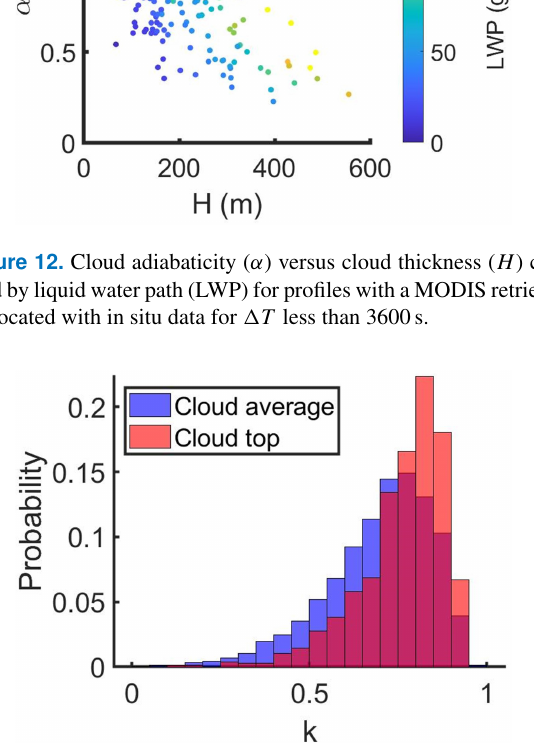
Figure 13. Probability density function for k averaged over the en- tire cloud layer (blue) or the top 10% of the cloud (red) for profiles with a MODIS retrieval co-located with in situ data for (cid:49)T less than